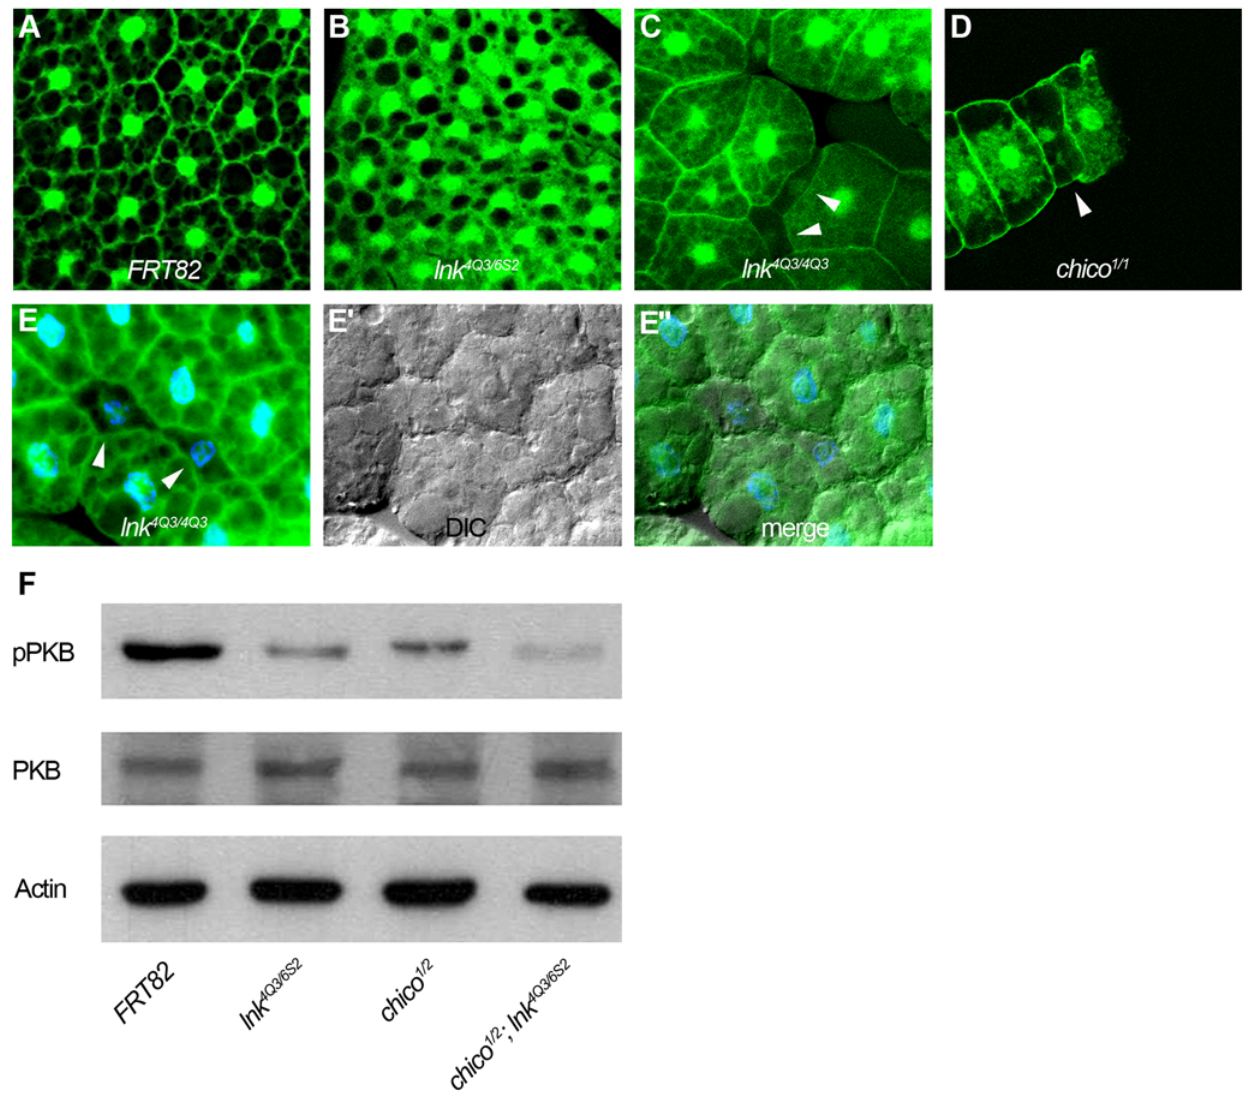
Figure 4. lnk affects IIS activity. (A–D) The IIS activity is visualized by the localization of the tGPH reporter. Compared to the signal at the membrane of wild-type fat body cells (A), the signal is diffuse and mostly cytoplasmic in lnk mutant larvae (B), indicative of low PI3K activity. In clones of lnk 4Q3 mutant cells (recognizable based on the size reduction and indicated by arrowheads), the signal is also almost absent from the plasma membrane (C). A similar effect is observed in chico mutant cells (D). (E–E 0 ) The strong reduction of membrane-localized tGPH is not due to structural defects of the lnk mutant cells as shown by differential interference contrast (DIC) microscopy (E 9 –E 0 ). (F) The phosphorylation of PKB is used to monitor IIS activity in larval extracts. Both lnk and chico mutants display a clear reduction of phosphorylated PKB. Note that the levels of PKB do not change. Actin is used as a loading control.